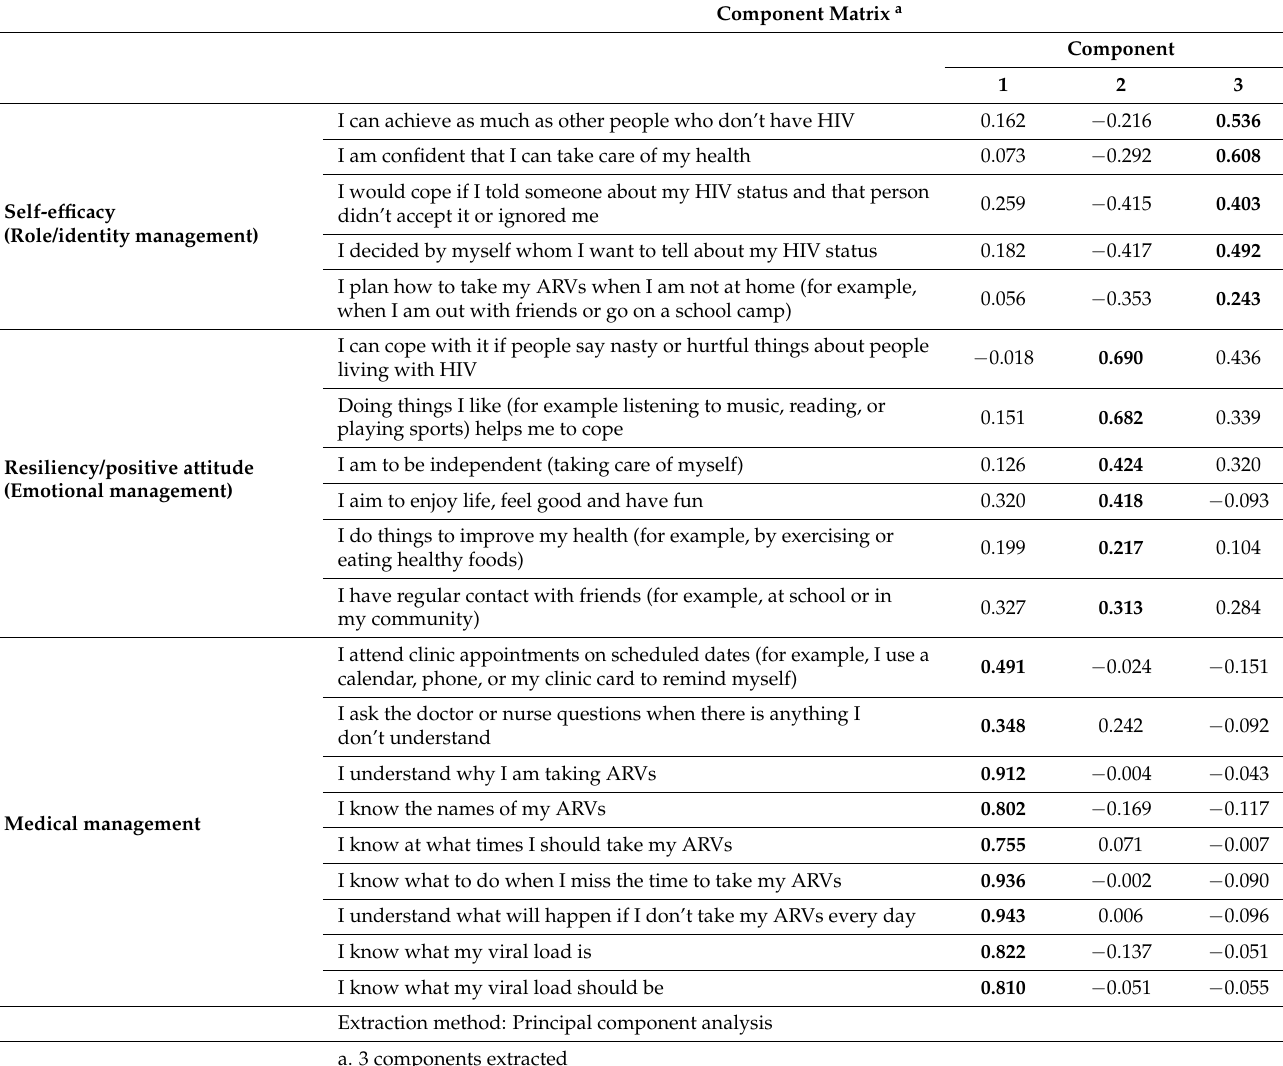
Table A1. Exploratory Factor Analysis (EFA) item factor